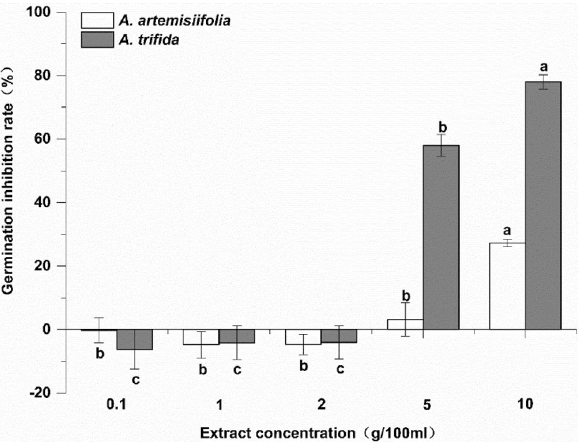
Figure 1. Autotoxicity of A. artemisiifolia and A. trifida extracts on their own seeds. Values are mean ± SE. Positive values indicate inhibited germination, and negative value indicate promoted germination. Different lowercase letters indicate that the seed germination inhibition rate of the same species at different concentrations was significantly different ( p < 0.05). A. artemisiifolia seeds were treated with A. artemisiifolia plant extract, and A. trifida seeds were treated with A. trifida plant extract. EA.a: A. artemisiifolia ; EA.t: A. trifida